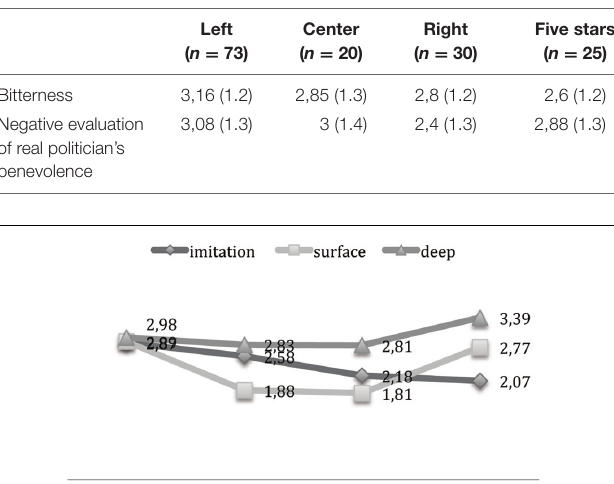
how deep parody determines an increase in negative evaluation particularly on the part of political congruent participants (rightists: in surface condition 1,25 vs. deep parody 2,83) different from leftists that are quite constant across conditions ( Figure 4 ). We can deduct that right voters (congruent with the parodied politician) are more affected by a deep parody than left, center or five star movement voters; in this case they evaluate the politician as more dangerous, but this evaluation does not impact on their level of